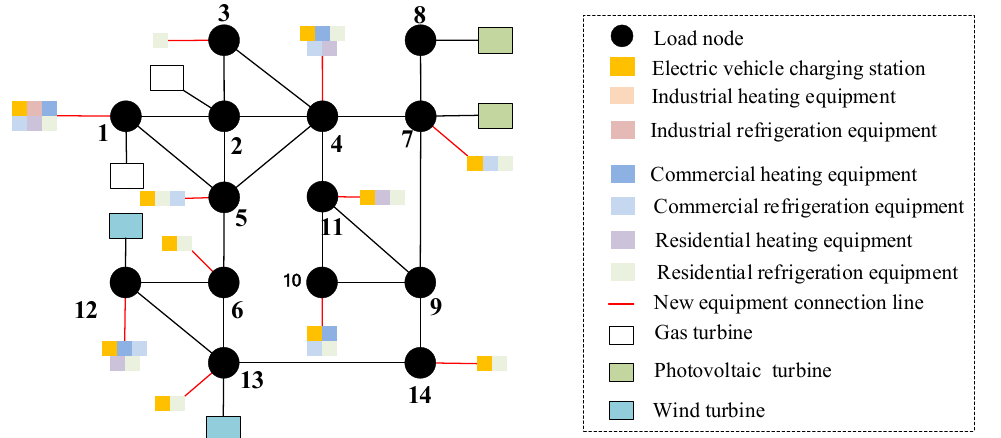
Figure 19. Morphological evolution of distribution network in 2021.